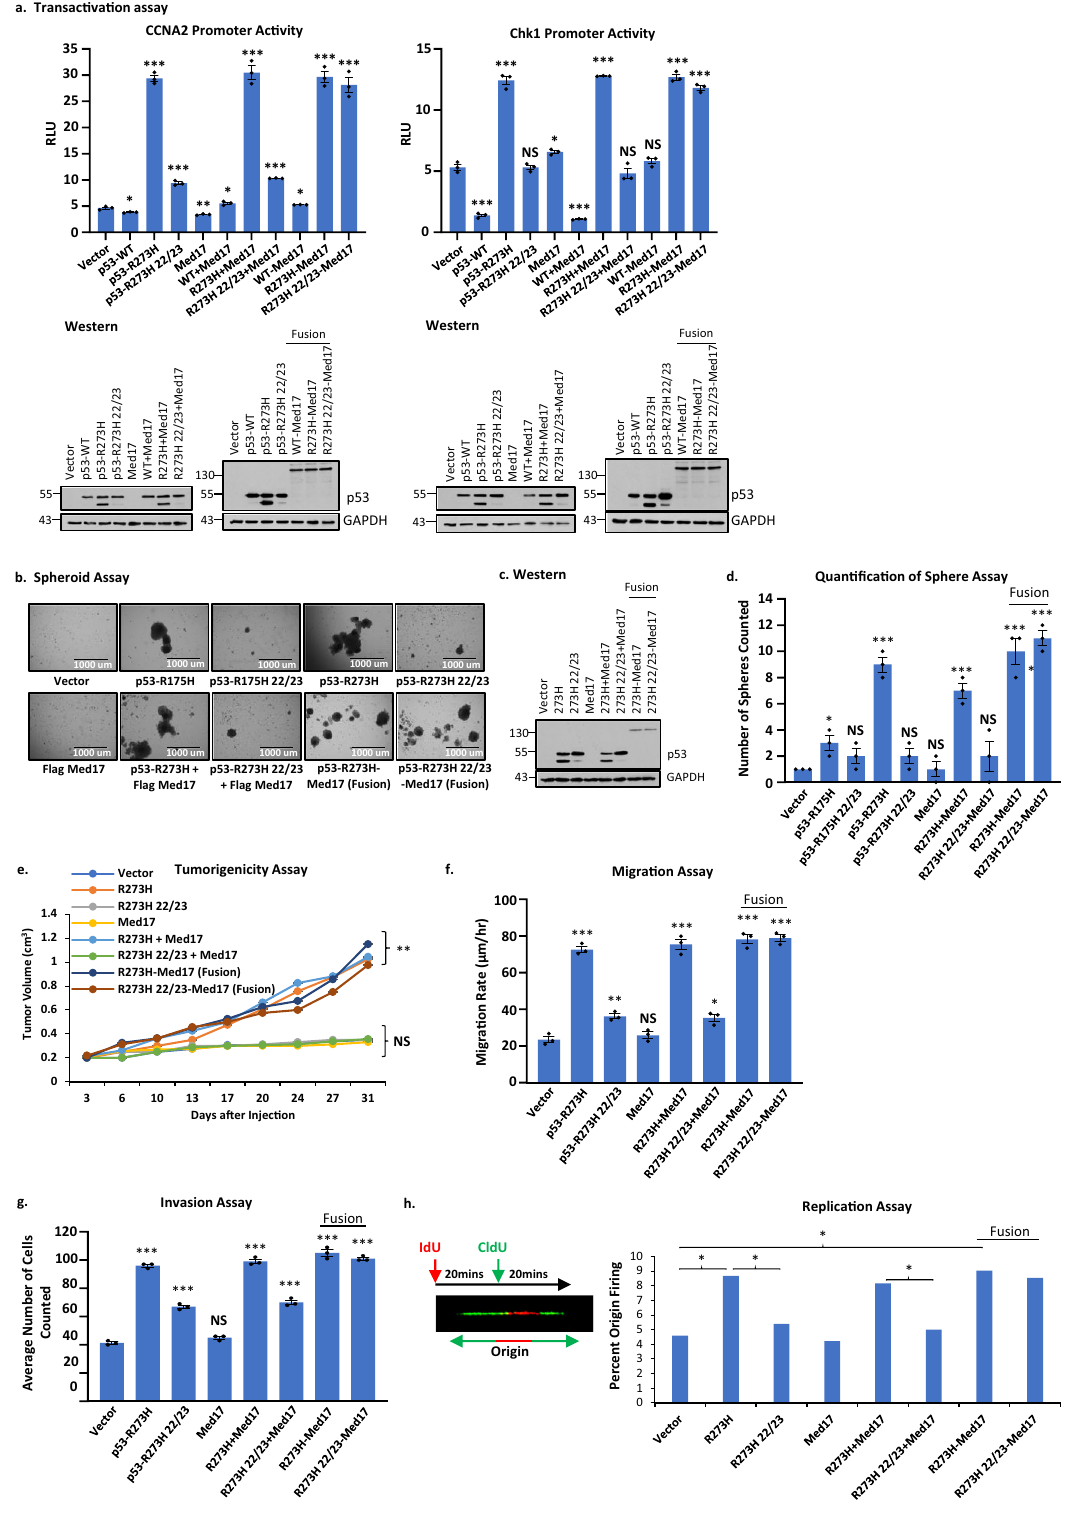
using H460 (WT p53 + / + ) and H1299 (p53 ‒ / ‒ ) cells and studying their growth rate, invasion and tumorigenicity in nude mice. As shown in Fig. 7f, g, PLK3 knockdown affects all the three properties irrespective of the presence of p53. This suggests that mutant p53 enhances the pro-oncogenic in fl uence of PLK3 by using it in its oncogenic